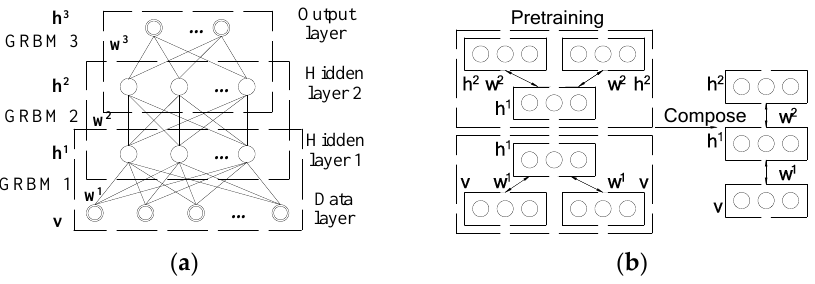
Figure 2. Schematic of the three-layer GDBM: ( a ) network structure; and ( b ) pretraining and composition of the GDBM.